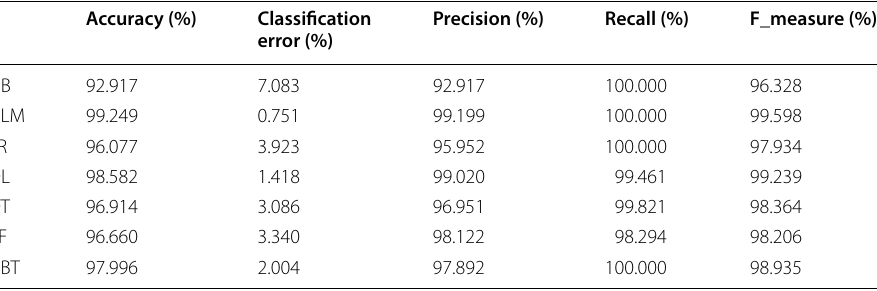
Table 9 Evaluation metrics for all implemented